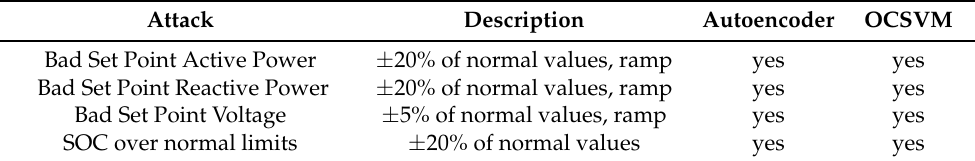
Table 2. Tests—Violating Safe Operating Conditions. Attack